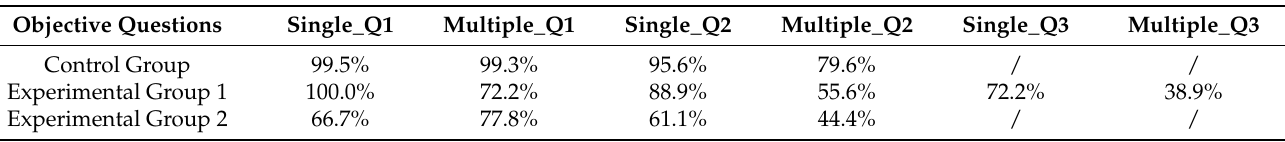
Table 7. The correct rate of objective questions in different conditions of all the groups. Q1 to Q3 indicate three objective questions for perceiving object size, number, and width,